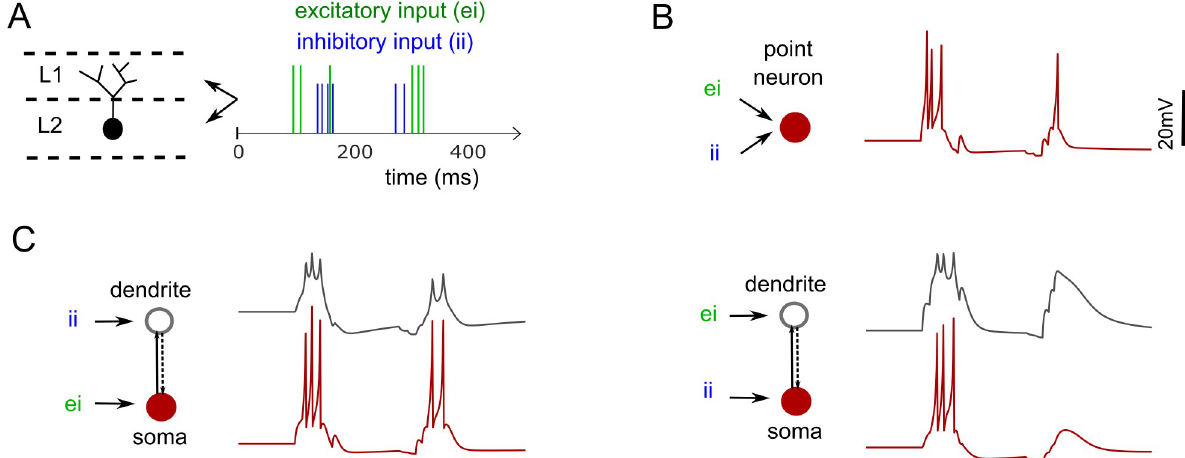
Fig 6. An example of segregated synaptic integration in a 2-compartment model. ( A ) A schematic illustration of a biological neuron with its soma and dendrites in different layers L1 and L2. This neuron receives two distinct presynaptic spike trains in L1 and L2. ( B ) A simplified point-neuron model integrates both the excitatory and inhibitory presynaptic spikes at the same point. ( C ) A 2-compartment model (see Fig 3) can integrate distinct inputs in different compartments. The model behaves differently (left vs. right) depending on the location of integration of distinct inputs. Excitatory weight = 8.0 and Inhibitory weight = 1.5 for B and C, respectively. Dendritic synapses scale 4x (see Fig 5E inset for